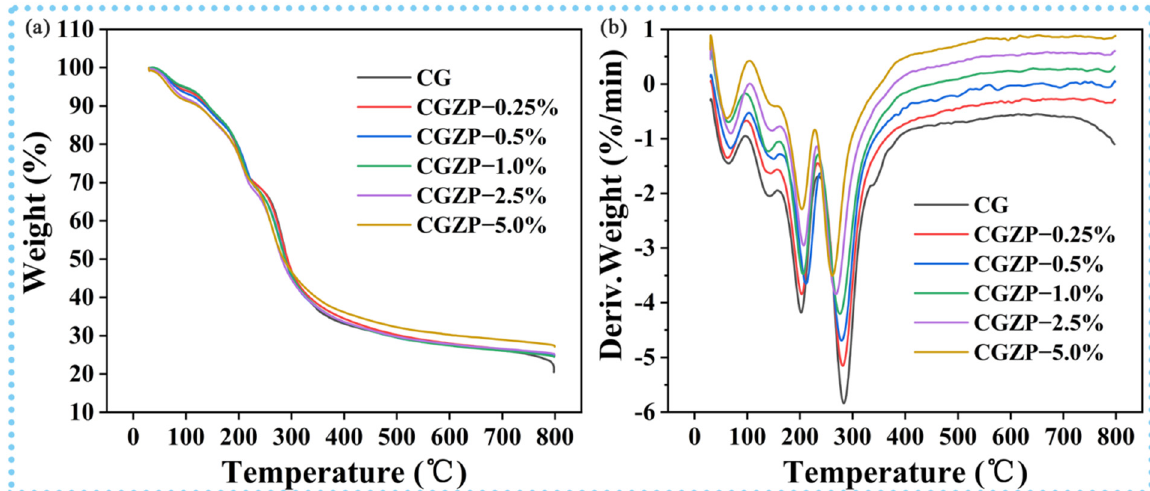
Figure 2. TG curves ( a ) and DTG curves ( b ) of CG and CGZP films.